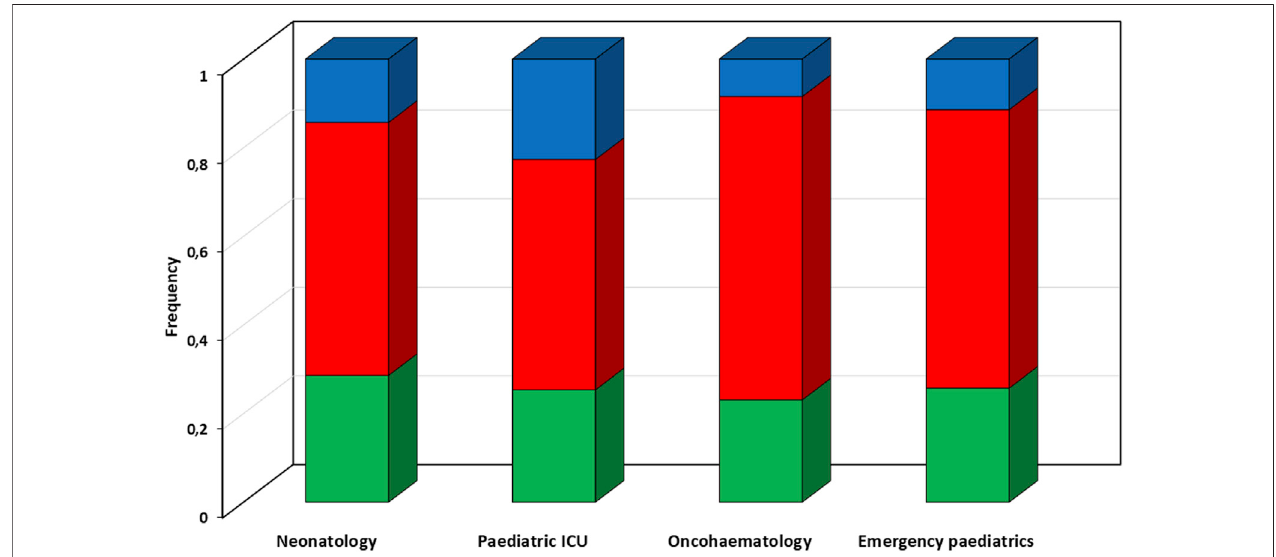
FIGURE 3 | Proportion of types of recommended dosing adjustments according to different paediatric settings. Red box, suggested dosing increase; green box, suggested dosing con fi rm; blue box, suggested dosing reduction. ICU, intensive care unit.